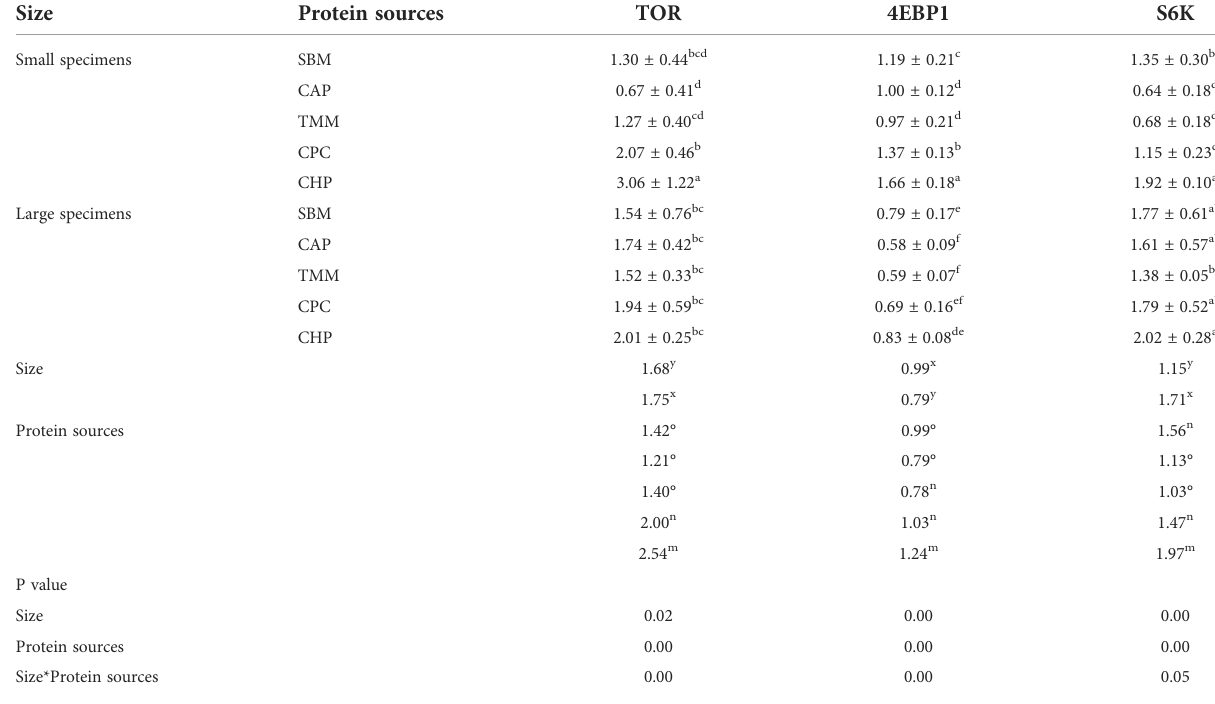
TABLE 9 Gene expression levels of protein synthesis in the muscles in different treatments.